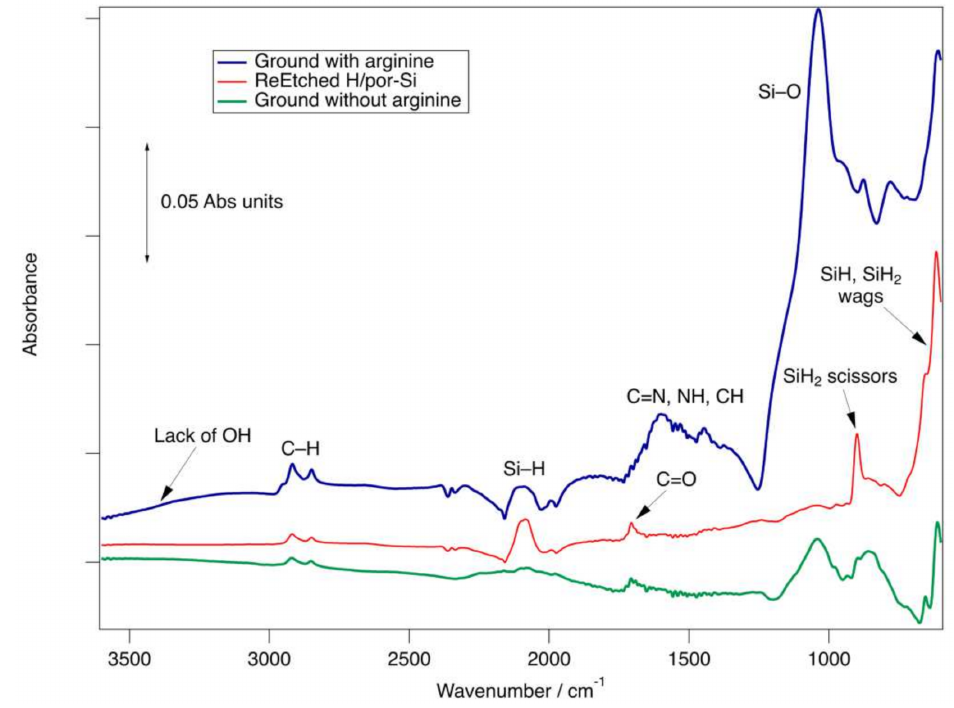
Figure 4. FTIR spectrum from 1200–3600 cm –1 . The red spectrum in the middle belongs to the as-etched por-Si. The green spectrum at the bottom belongs to por-Si ground for 4 h without arginine. The upper blue spectrum is obtained after a 4-h grind of por-Si with arginine. The sample ground with arginine was rinsed to remove excess and physisorbed arginine. CO 2 and H 2 O features are due to incomplete purging of atmospheric